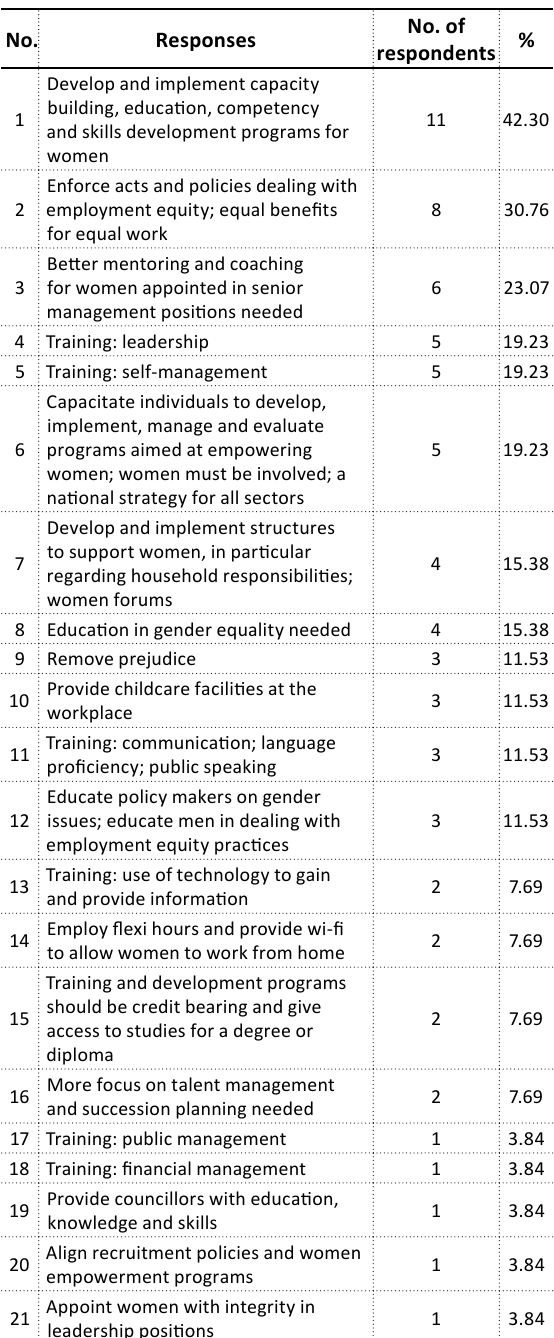
Table 11. Q3. What would you suggest should receive particular attention in the design of a women empowerment program in local government? What do you think requires